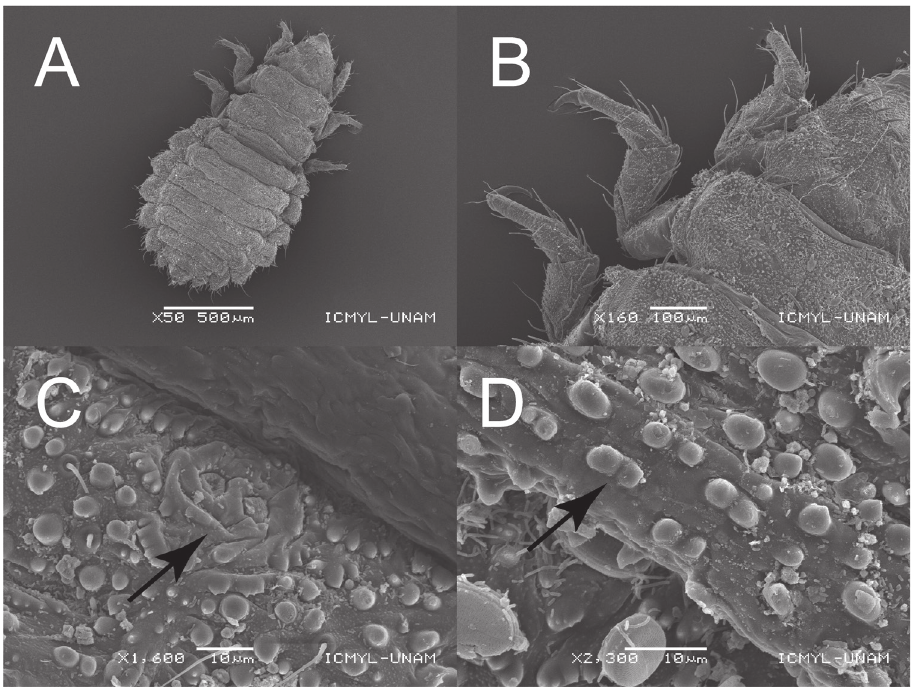
Figure 5. Scanning electron micrographs of larva of Mejicanotrichia tridentata (Bueno-Soria & Hamilton, 1986) A habitus, dorsal B left thoracic legs, dorsal C lacunae of abdominal segment V D dark ornamental pigments of abdominal tergites. Scale bars: 500 µm ( A ); B: 100 µm ( B ); C: 10 µm ( C, D